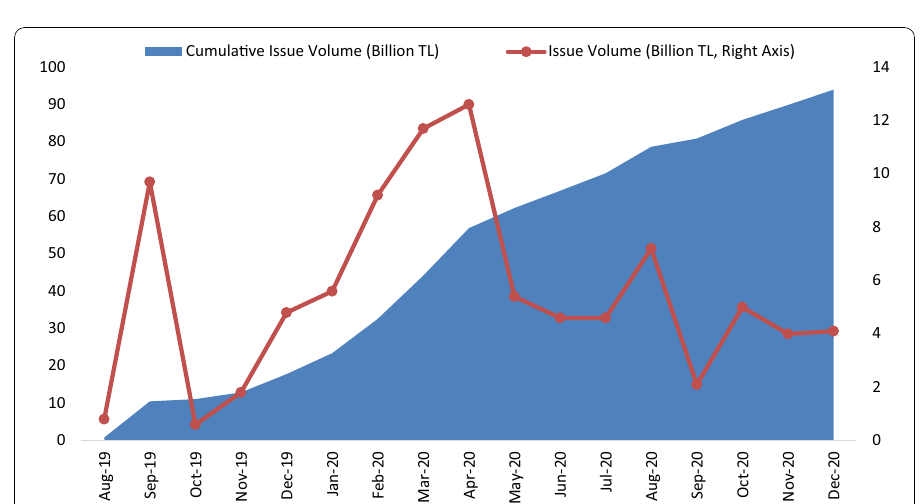
Fig. 2 The development of TLREF-based securities (billion TL). Source : Authors’ collections (Public Disclosure Platform PDP